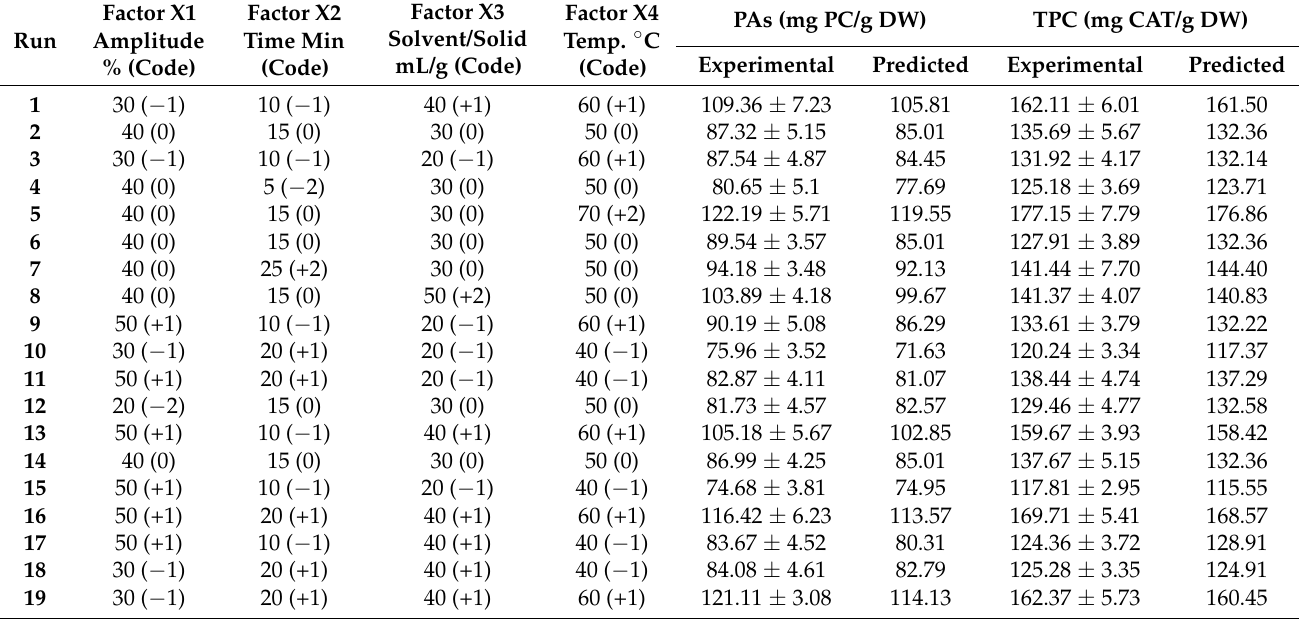
Table 1. Response surface design with experimental and predicted